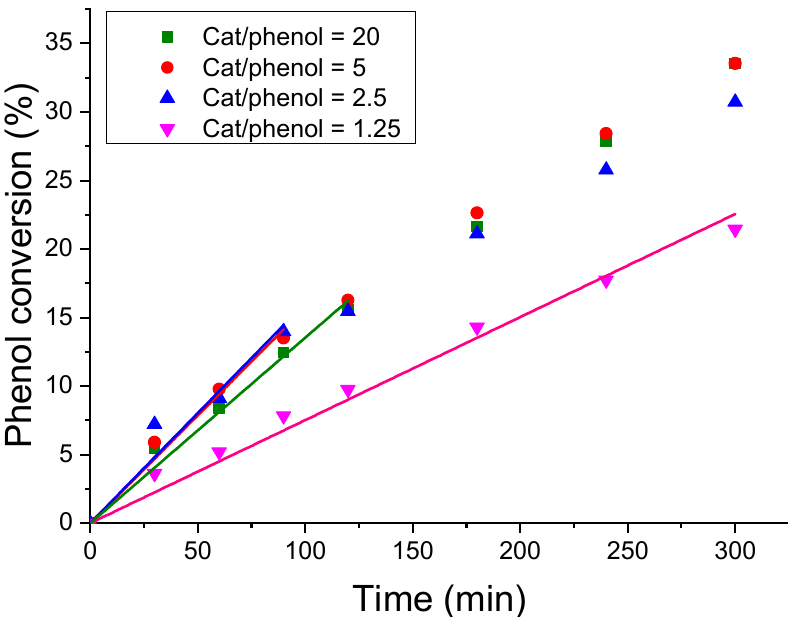
Figure 6. Effect of the catalyst/phenol mass ratio on the reaction rate, fixing T = 40 ◦ C and an initial Figure 6. E ff ect of the catalyst/phenol mass ratio on the reaction rate, fi xing T = 40 °C and an initial phenol concentration of 25 ppm. Continuous lines represent the linear fit necessary to calculate the phenol concentration of 25 ppm. Continuous lines represent the linear fi t necessary to calculate the observed reaction rate ( r obs observed reaction rate ( r obs ).